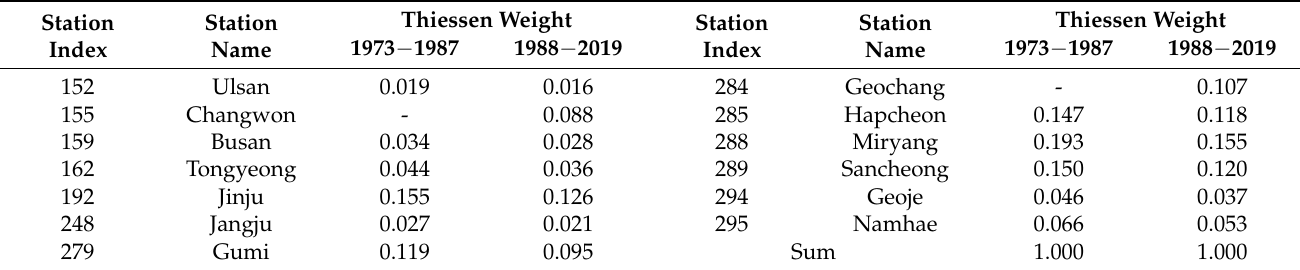
Table 4. Thiessen weight by rainfall station.